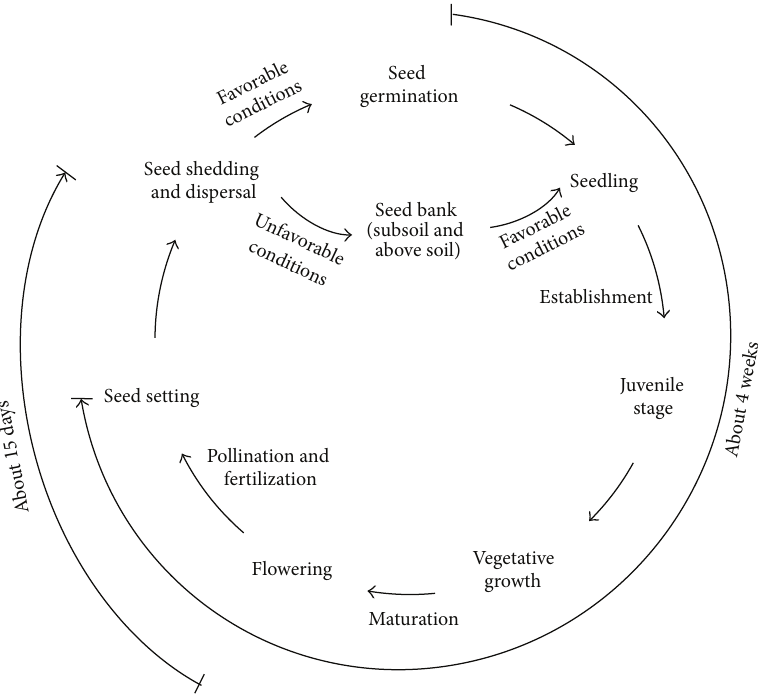
Figure 1: Life cycle of Parthenium hysterophorus